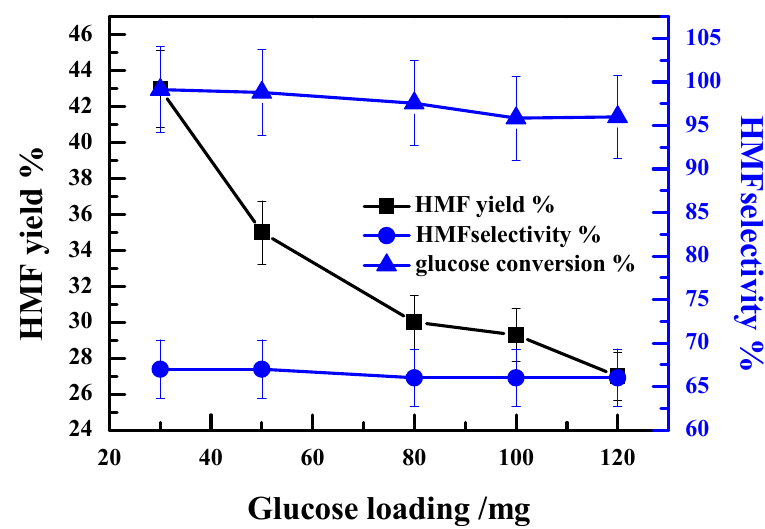
Figure 5. Effect of Substrate loading on glucose conversion.Reaction conditions: 0.15 g ZrOCl 2 , 0.05 g [HO 2 CMMIm]Cl, 3.0 g isopropanol, 3 h reaction time, 150 ◦ C reaction temperature.